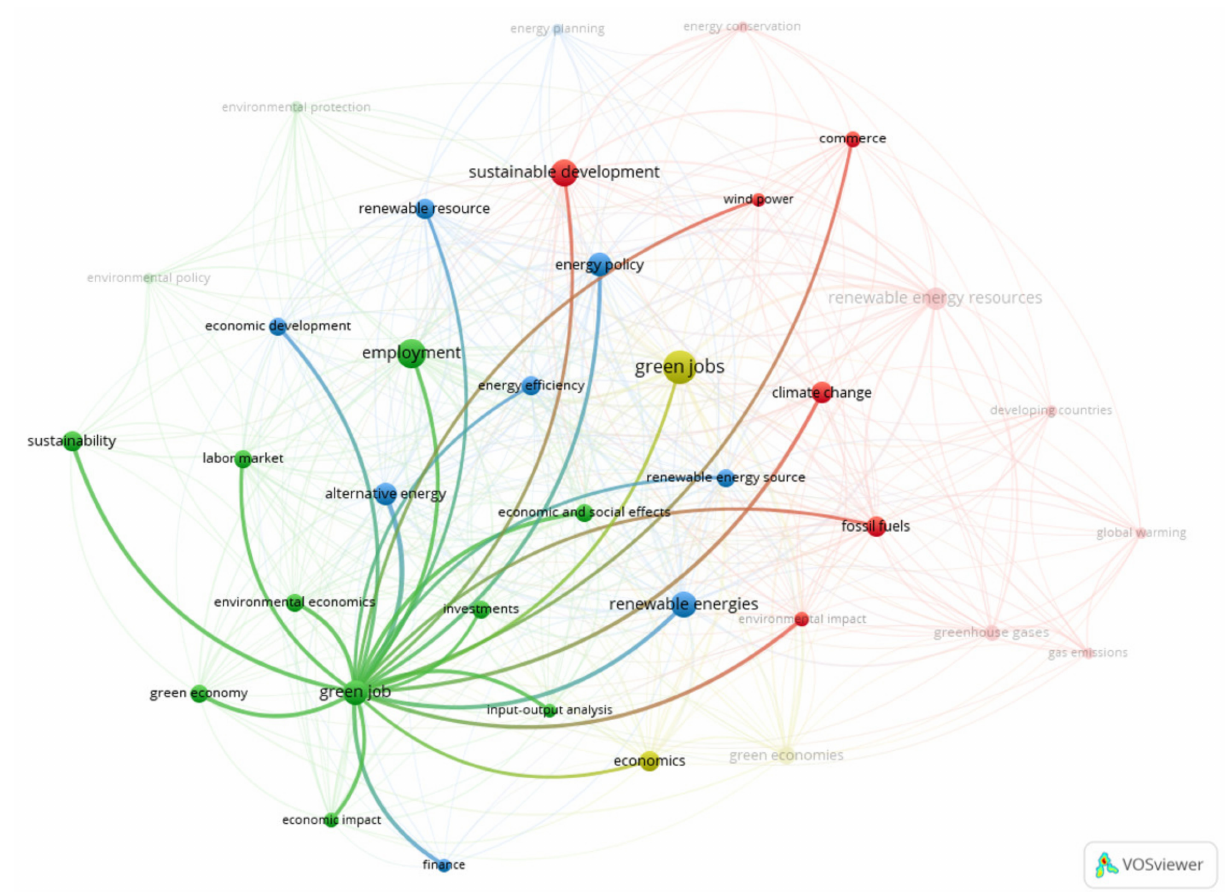
Figure 8. Keyword “green job” relations with other keywords. Source: Authors’ elaboration in VOSviewer software (1.6.18